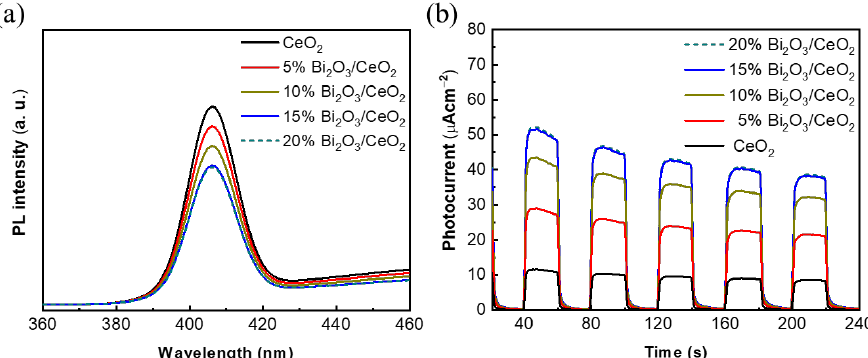
Figure 7. PL spectra ( a ) and transient photocurrents ( b ) of pure CeO 2 and Bi 2 O 3 /CeO 2 heterojunc- tions as stated.